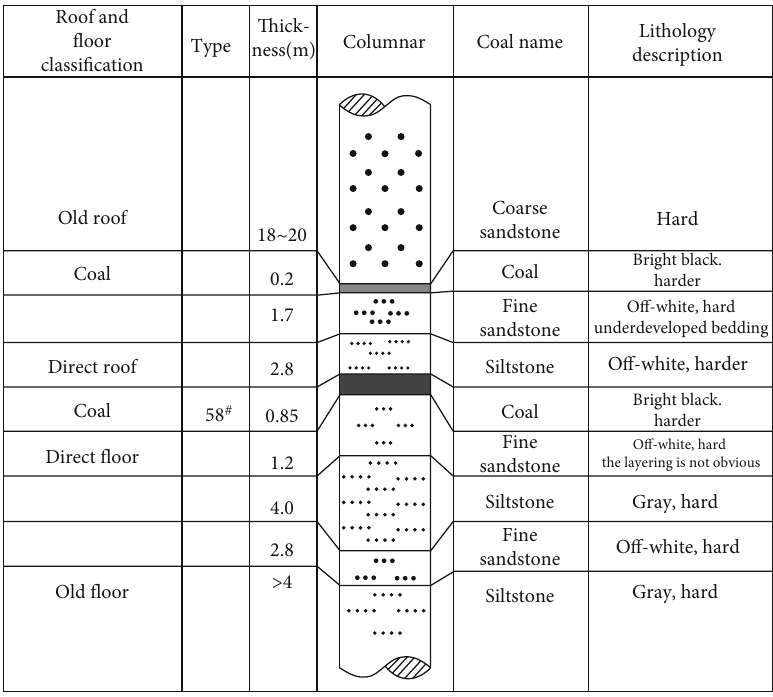
Figure 1: Top and bottom